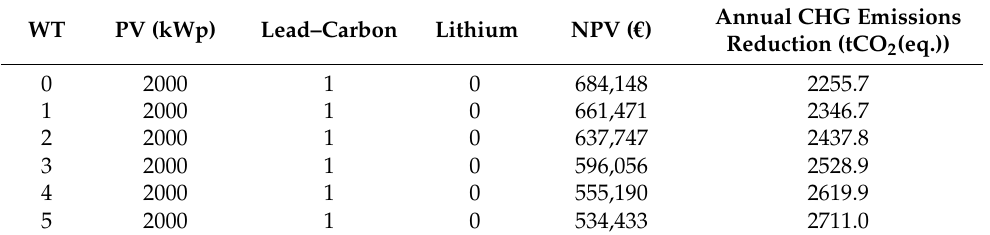
Table 6. Pareto-optimal set of the HMU campus microgrid considering the installation of a MV station.